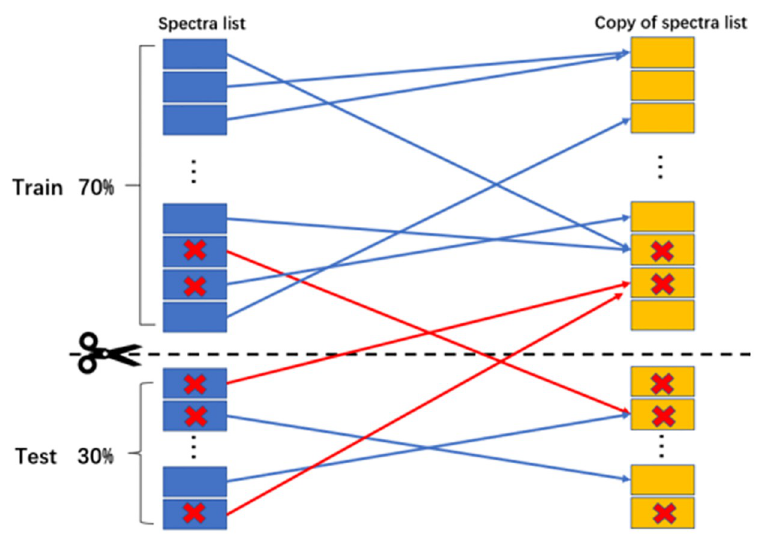
Fig 7. Schematic representation of bidirectional isolation